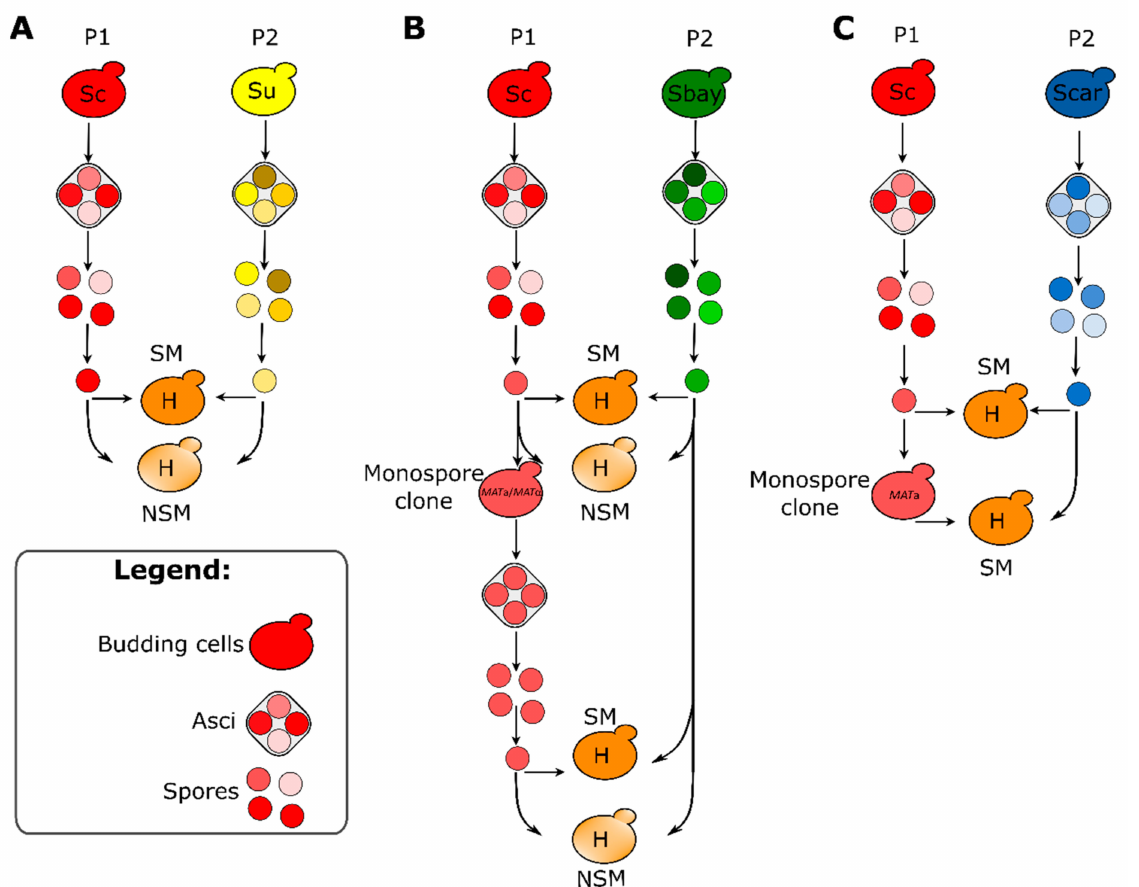
Figure 1. Overview of hybridization scheme used in the present study. Three crosses were attempted: ( A ) Sac- charomyces cerevisiae × Saccharomyces uvarum RC2-10, ( B ) S. cerevisiae × Saccharomyces bayanus NBRC1948 and ( C ) S. cerevisiae × Saccharomyces cariocanus CBS8841. S. cerevisiae × S. uvarum RC2-10 and S. cerevisiae × S. bayanus NBRC1948 crosses were carried out in staggered mating (SM) and non-staggered mating (NSM), while S. cerevisiae × S. cariocanus cross in SM only. Mating involved spores from wild-type strains and/or spores from monospore clones in S. cerevisiae × Scheme 2. and S. cerevisiae × S. bayanus NBRC1948 crosses. Mating involved either spores from wild-type strains or mating-competent cells in S. cerevisiae × S. cariocanus CBS8841 cross. Abbreviations: SM, staggered mating; NSM, non-staggered mating; Sc, S. cerevisiae ; Su, S. uvarum ; Sbay, S. bayanus ; Scar, S. cariocanus ; P1, parental strain 1; P2, parental strain